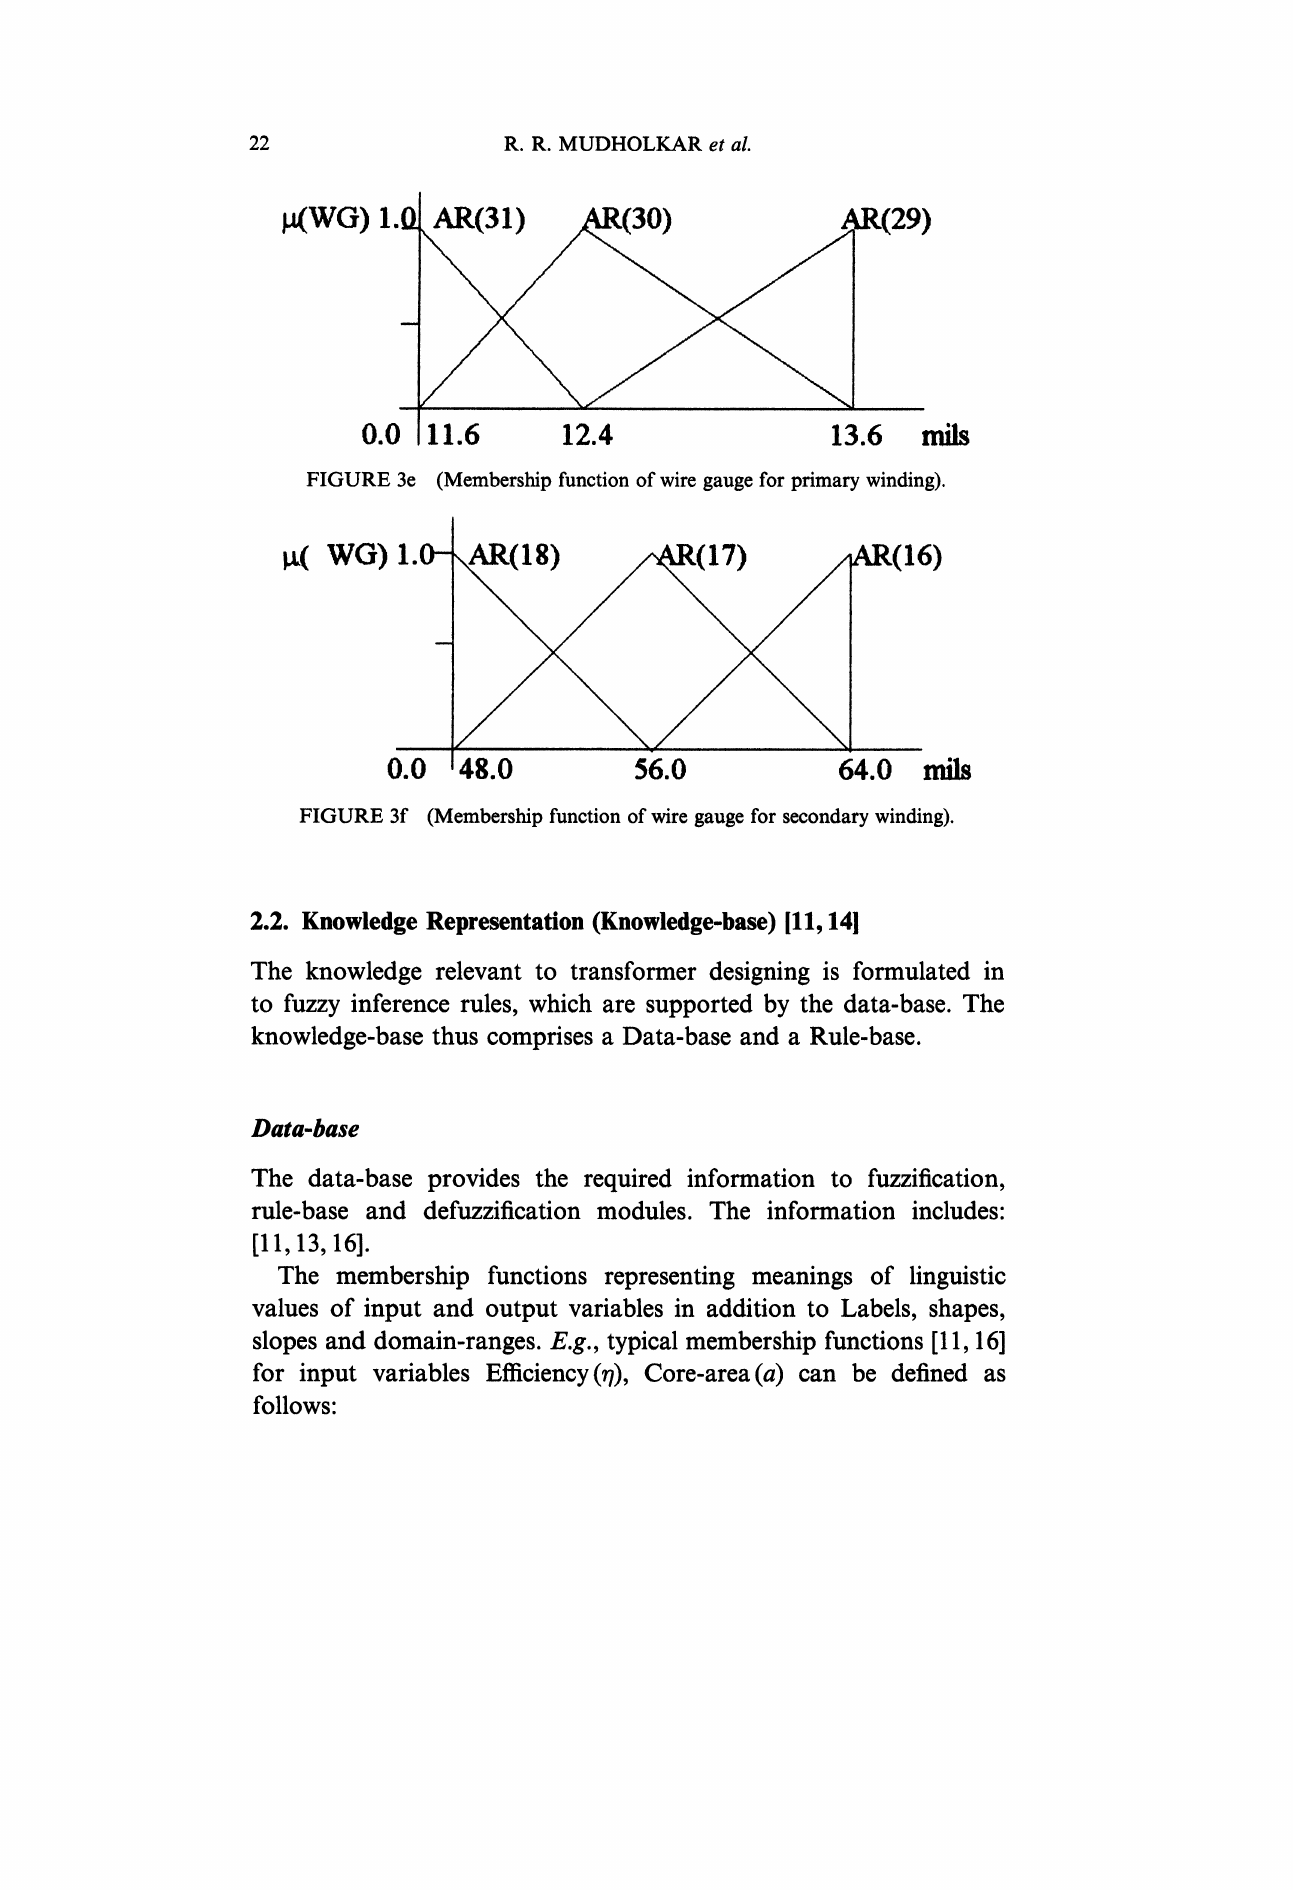
FIGURE 3e (Membership function of wire gauge for primary winding).